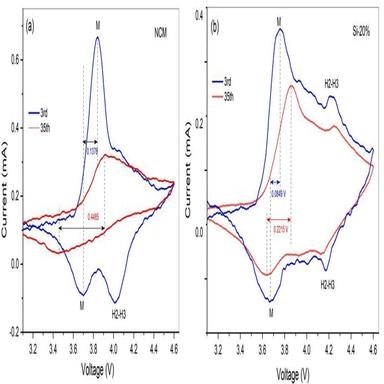
CV curves of (a) NCM and (b) Si-20 % after 3rd and 35th cycles.